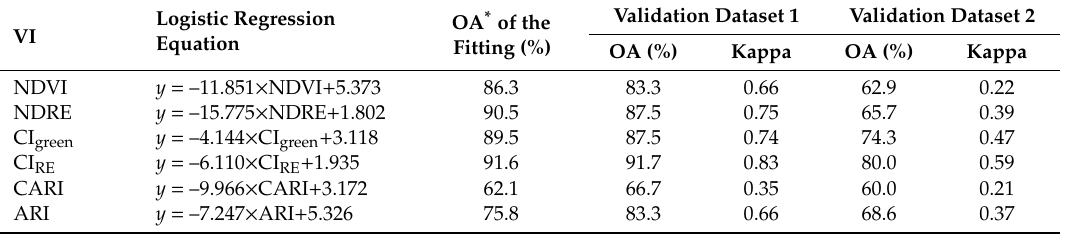
Table 3. The logistic regression models for di ff erent vegetation